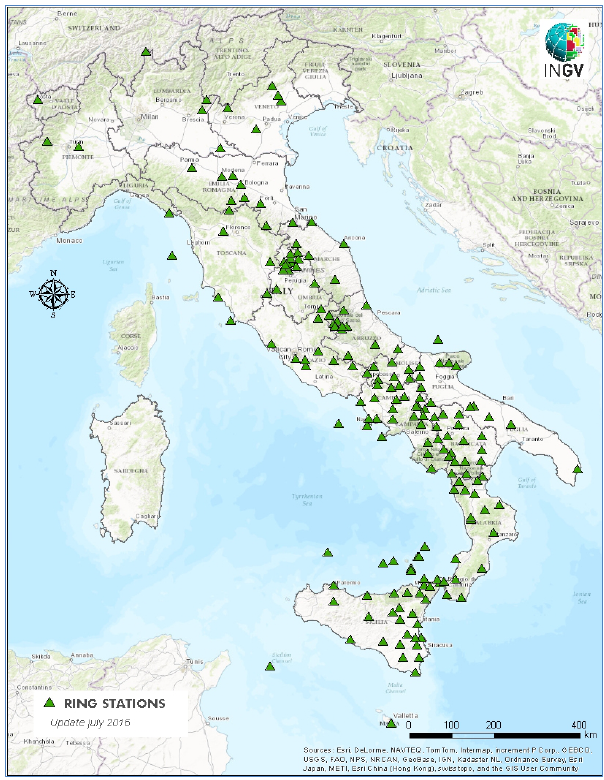
Figure 3. RING, the Italian GPS National network.